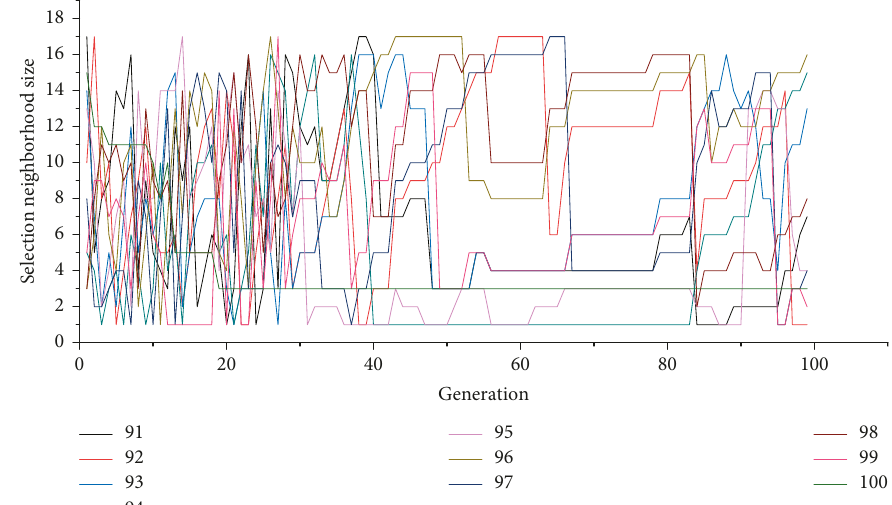
Figure 12: Variation of selection neighhorhood sizes for individuals 91 to